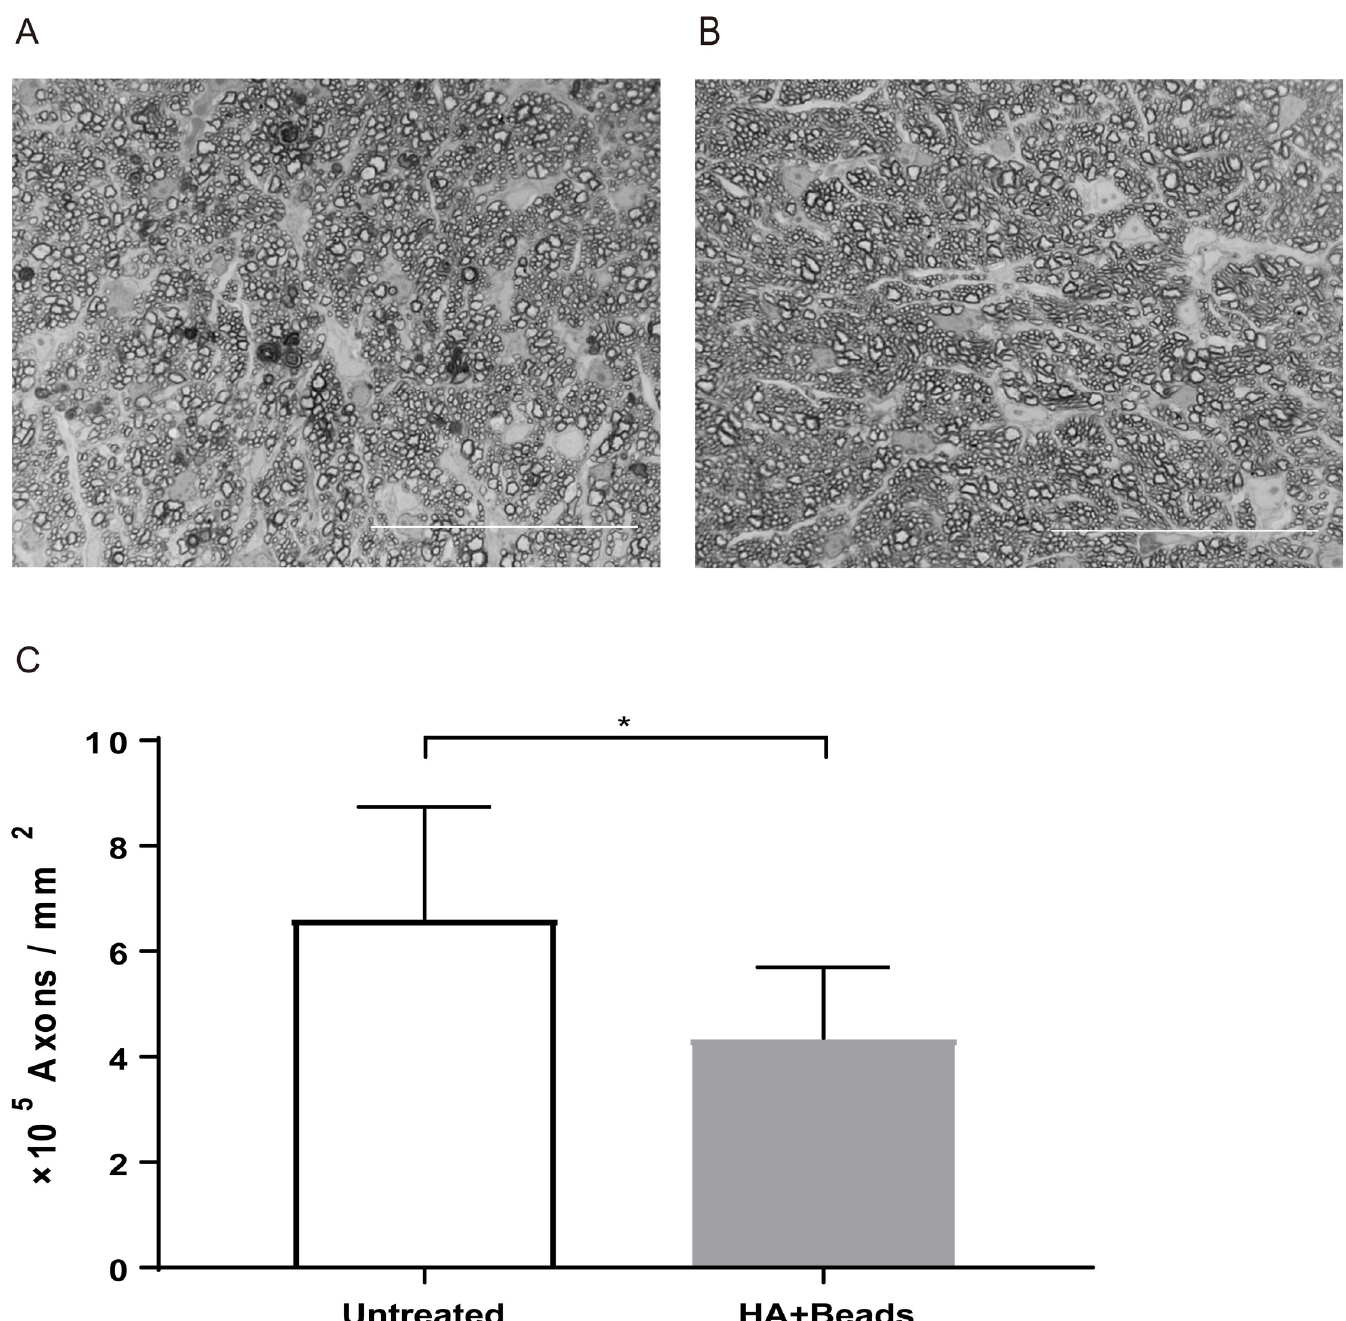
Fig 8. Axon loss of at 30 days post inducing ocular hypertension. (A) The axon damage of hyaluronic acid with beads injected eye (HA with beads group). (B) The axon in untreated eye. (C) Comparison of axonal damage between hyaluronic acid (HA) + beads group (n = 5) and untreated group (n = 4). � p < 0.001. Scale bar = 50 μ